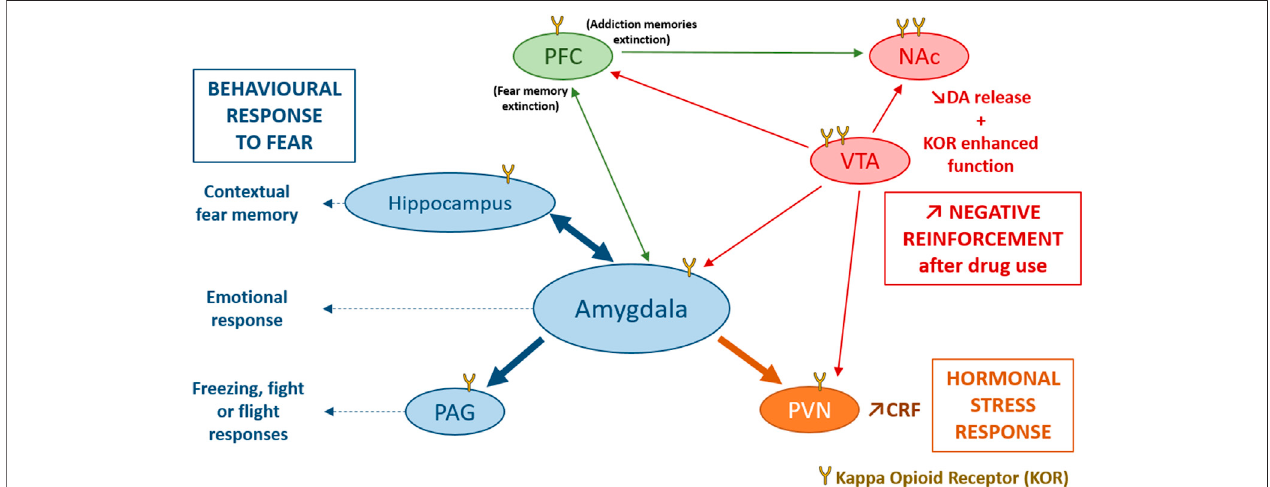
FIGURE 2 | Involvement of the DYN/KOR system in response to stress. KOR activation induce an activation of the hypothalamo-pituitary-adrenal axis mainly throughanincreaseinCRFreleasebythePVN,participatinginthehormonalstressresponse(Van ’ tVeerandCarlezon,2013).Theamygdala,thehippocampus andthe PAG are directly modulated by KOR and modulate contextual fear memory, emotional response and the freezing, fi ght or fl ight responses to fear. Stress could also induce dynorphin release and activates KOR in VTA dopaminergic neurons, inducing a decrease of DA release in several brain structures such as, the PFC, the NAc, the amygdala and the PVN (Karkhanis et al., 2017). After stress or trauma, some interesting processes could be observed: an enhanced function of KOR in VTA, and NAc, an endogenous opioid withdrawal, or an enhanced negative reinforcement after drug use, that may potentiate the risk of comorbid substance use disorder. CRF, Corticotropin Releasing Factor; DA, dopamine; KOR, Kappa Opioid Receptor; NAc, Nucleus Accumbens; PAG, periaqueductal gray; PFC, PreFrontal Cortex; PVN, ParaVentricular Nucleus of the hypothalamus; VTA, Ventral Tegmental Area.